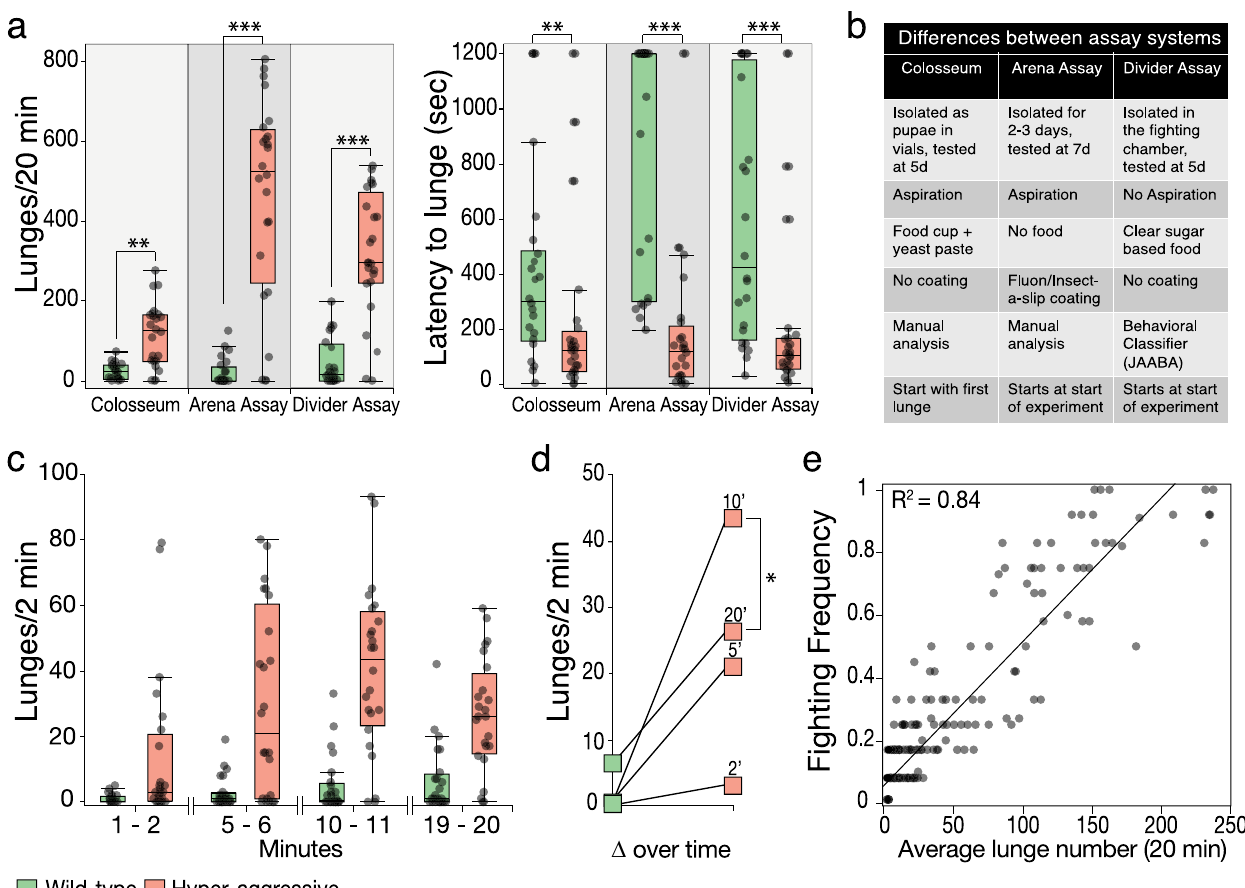
Fig. 4 Comparison of the Divider Assay with other aggression assays. a Lunge numbers (left plot) and latencies to lunge (right plot) in two established assays, the Colosseum assay and the Arena Assay, show similar differences between control and hyper-aggressive strains as in the Divider Assay. In all assays the differences are statistically signi fi cant (Wilcoxon rank-sum test, n = 22 – 24 per group). b Overview of the parameter differences in the three assay systems: age, fl y handling, presence or absence of food, method of analysis, and duration of the experiment are different in the three assays. The Divider Assay is easiest to run because fl ies are collected, isolated, and loaded in a single step and lunges are analyzed in an automated manner. c Analysis of lunges in 2 min time bins shows signi fi cant differences in lunge numbers between the low and high aggression strains (Wilcoxon rank-sum test, 1 – 2 min, p = 0.001; 5 – 6 min, p = 0.0009; 10 – 11 min, p < 0.0001; 19 – 20 min, p < 0.0001, n = 24). d Plot of the median differences between the low (green squares) and high (red squares) aggression strains The largest difference between the two strains occurs at the 2 min bin at 10 min of videotaping. Median lunge numbers decrease signi fi cantly by 20 min in the hyper-aggressive strain (Wilcoxon rank-sum test, Aggr 10 ′ vs. Aggr 20 ′ , p = 0.03, n = 24). In the low aggression strain median lunge number keep increasing over time and reach the highest levels in the last 2 min time bin (Wilcoxon rank-sum test, CS 2 ′ vs. CS 20 ′ , p = 0.0 2 ′ , Wilcoxon rank-sum test, n = 24). e Fighting frequencies, the percentage of pairs that show clear dominance between both fl ies, correlates very signi fi cantly with lunge numbers as previously shown ( R 2 = 0.84, p < 0.0001, 10 – 12 fi ghting pairs per data point, n = 213). Boxplots show the median, fi rst and third quartiles as boxes, with whiskers representing the 5 and 95%